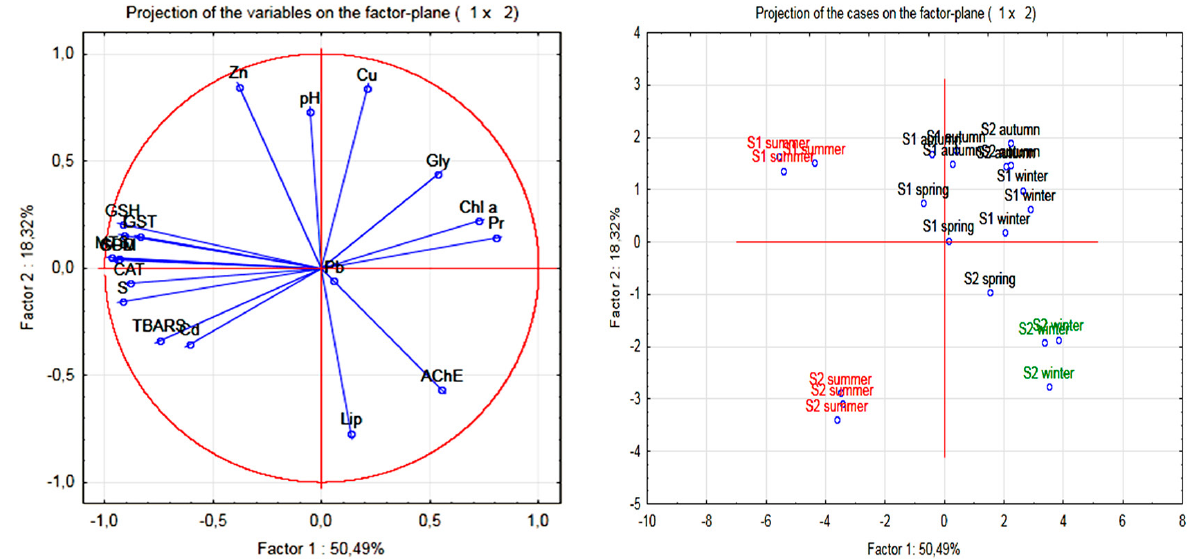
Fig. 4. – Results of PCA represented by two factors (F1=50.49% and F2=18.32%) and produced by biochemical variables and trace element concentrations in P. cultrifera from two sites in the Gulf of Tunis. Pr, proteins; Lip, lipids; Gly, glycogen; TBARS, thiobarbituric acid; CAT, catalase; SOD, superoxide dismutase; GSH, glutathione; GST, glutathione-S-transferase; AChE, acetylcholinesterase; MT, metallothionein; Cd, cadmium; Zn, zinc; Cu, cooper; Pb, lead; T, temperature; S, salinity; Chl a , chlorophyll a . (A) Projection of the variables on the factor- plane 1-2. (B) Projection of the cases on the factor-plane